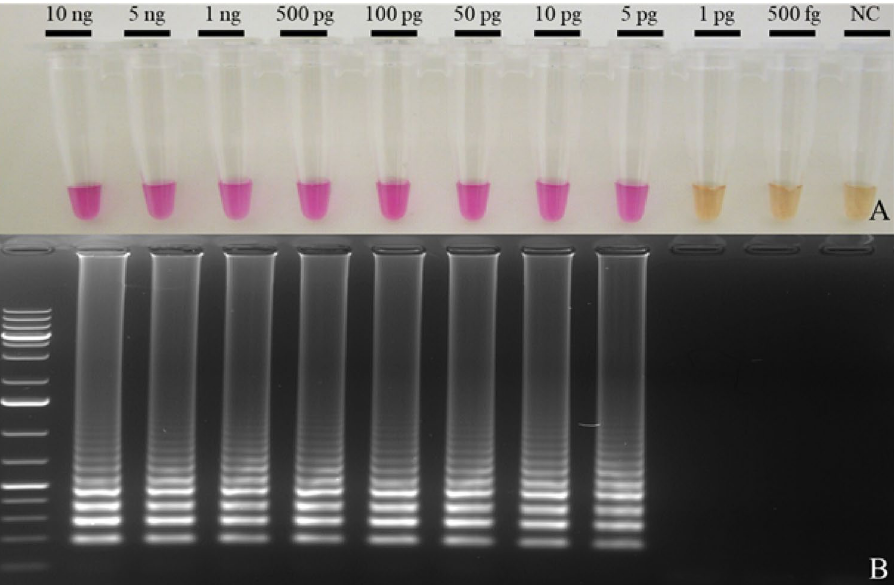
Figure 6. Determination of the LOD of the LAMP assay for T. controversa . ( A ) The LAMP assay was carried out with serial dilutions of DNA of T. controversa isolate OL and the result was photographed under daylight condition. ( B ) The products were separated on a 2% agarose gel and visualized under UV 360 nm . NC: water control; Ladder: size marker 1 kb plus.